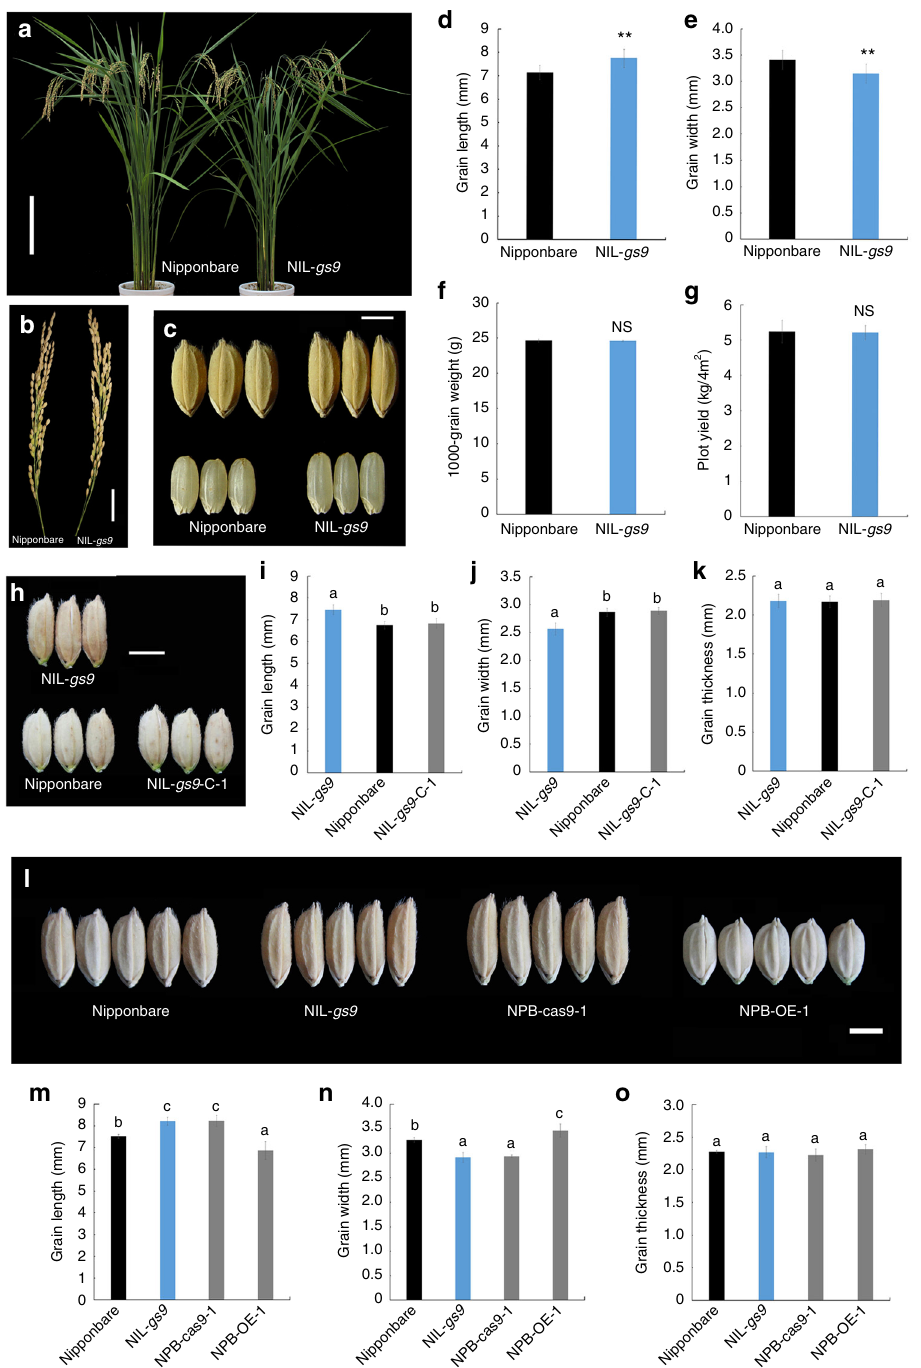
Fig. 2 Con fi rmation of GS9 in regulating grain shape. a – g Con fi rmation by using near-isogenic line. Morphology of whole plant ( a ), panicle ( b ), grain shape ( c – e ) and weight ( f ), and yield ( g ) of the near-isogenic line NIL- gs9 and Nipponbare during maturation from the same planting condition in the summer of 2014. Scale bar, 20 cm ( a ), 3 cm ( b ), 3 mm ( c ). Data in d and e are given as means± SD ( n = 30); ** signi fi cant difference ( P < 0.01, t -test). NS not signi fi cant difference ( t -test). h – k Complementary test. Grain shape ( h ), length ( i ), width ( j ), and thickness ( k ) of NIL- gs9 and its complementary transgenic line NIL- gs9 -C, and their parent Nipponbare from the same planting condition in 2015. Scale bar, 3 mm. Data are given as means ± SD ( n = 30). l – o , CRISPR/Cas9 editing and overexpression of GS9 in Nipponbare. Comparison of grain shape ( i ), length ( m ), width ( n ), and thickness ( o ) among different lines from the same planting condition in 2016. NPB-cas9-1, a null gs9 mutant in Nipponbare background created by CRISPR/Cas9 editing system; NPB-OE-1, a GS9 overexpression line in Nipponbare background. Scale bar, 3 mm. Data in m – o are given as means ± SD ( n = 20). The presence of the different lowercase letters in i – k and m – o denotes signi fi cant difference between the means ( P < 0.01, one-way